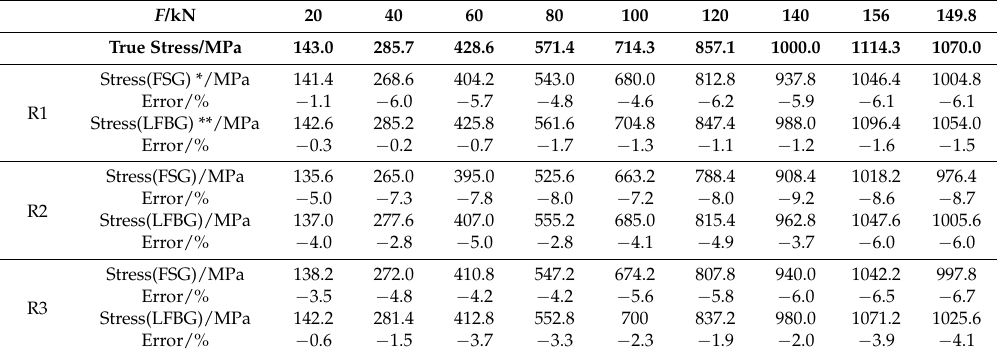
Table 2. The measurement errors in calculated stresses from the strains obtained from the FSGs and LFBG